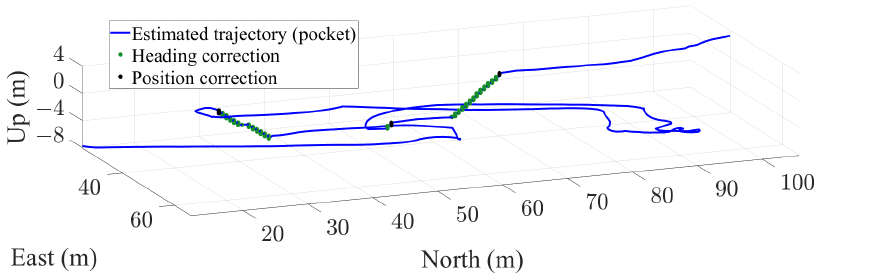
Figure 21. Estimation of a trajectory in a traffic hub with the smartphone in the front pocket of the trousers. The green and black dots represent, respectively, the points where heading and position updates are